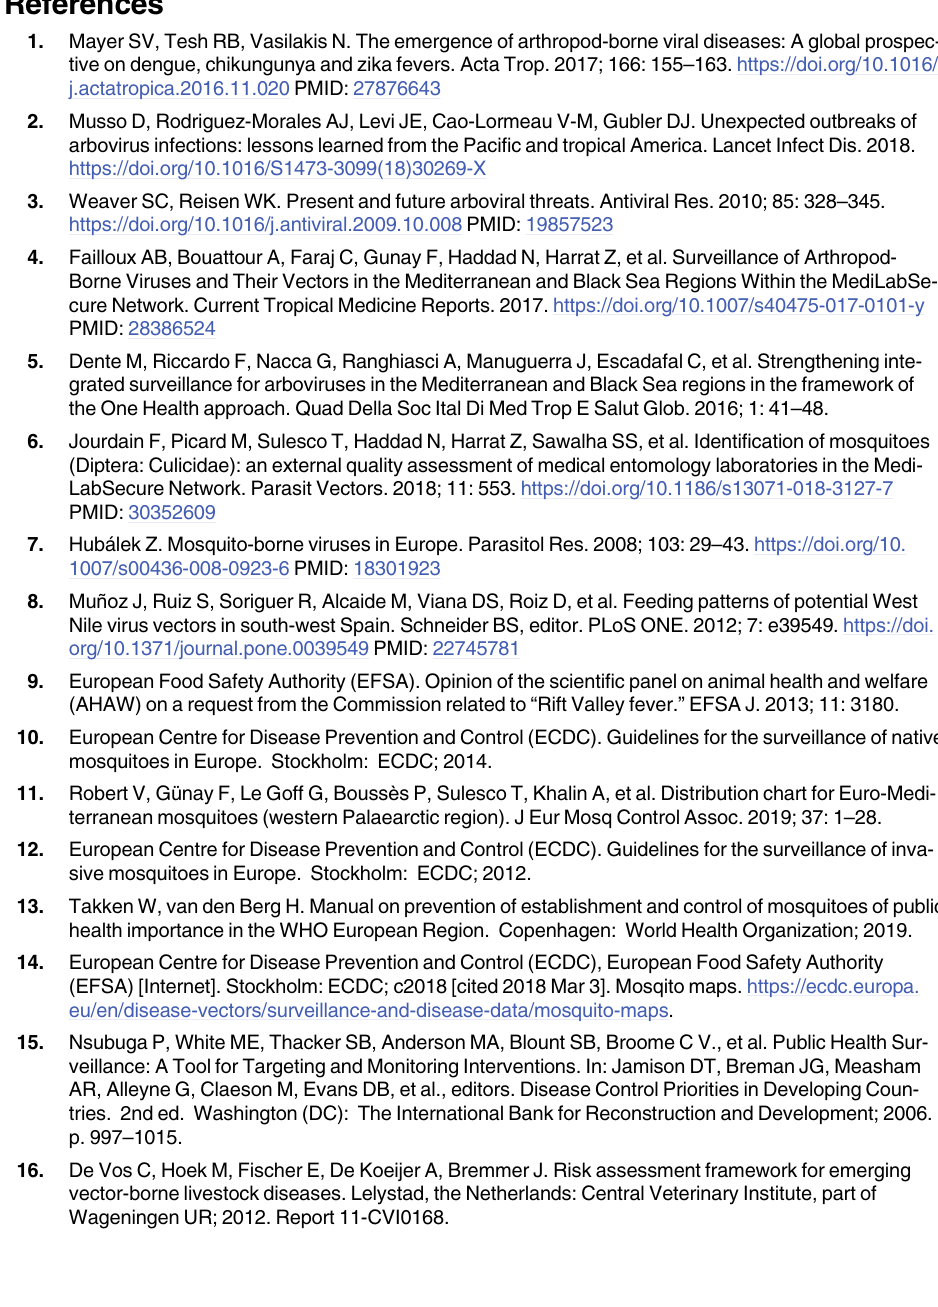
S1 Table. The 19 member laboratories of the medical and veterinary entomology MediLab- Secure network who took part in the online